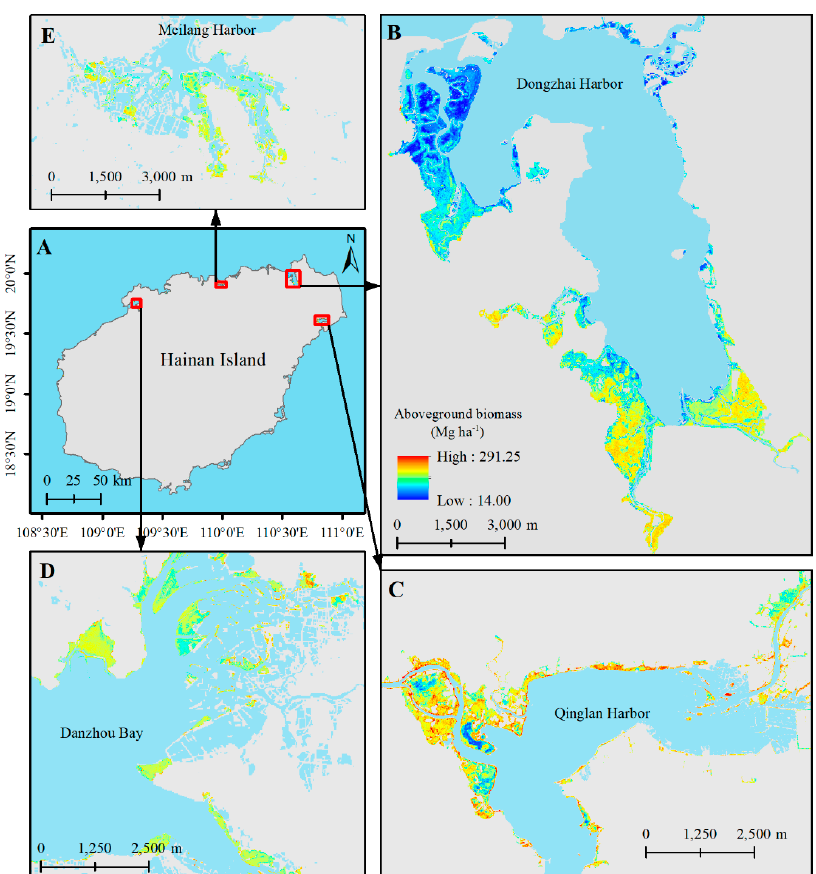
Figure 7. Mangrove aboveground biomass map of Hainan Island at 10 m spatial resolution. ( A ) Whole